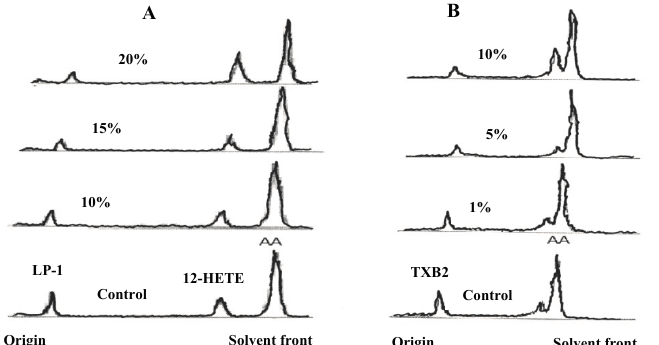
Figure 2. Effects of pig ( Sus barbatus ) plasma on COX and LOX medicated metabolism of AA.